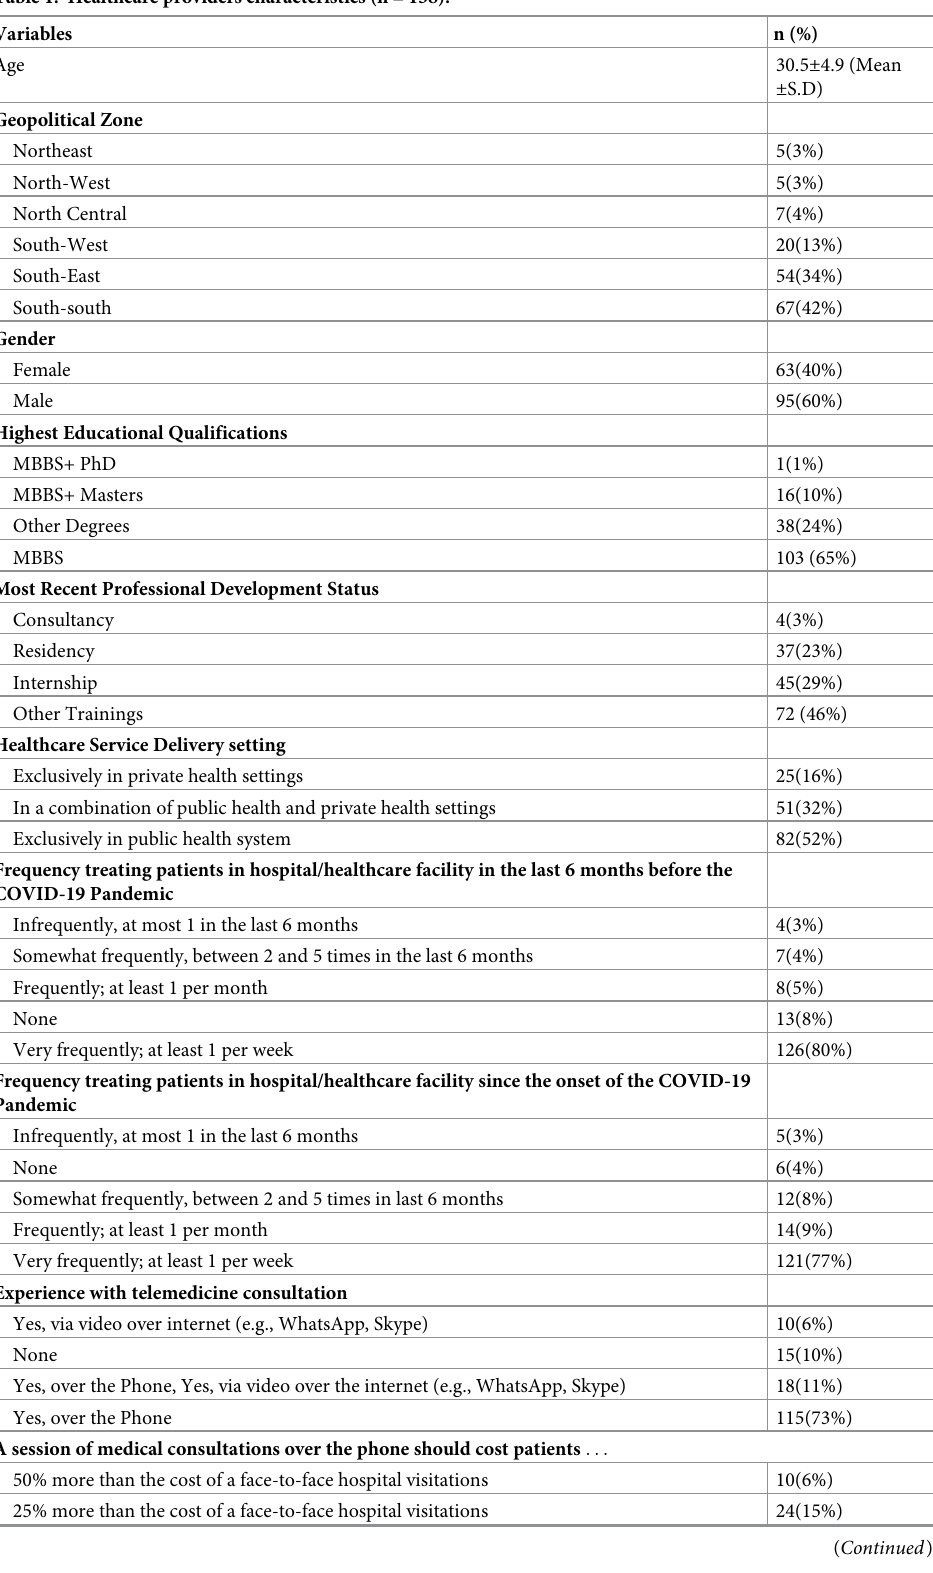
Table 1. Healthcare providers characteristics (n =